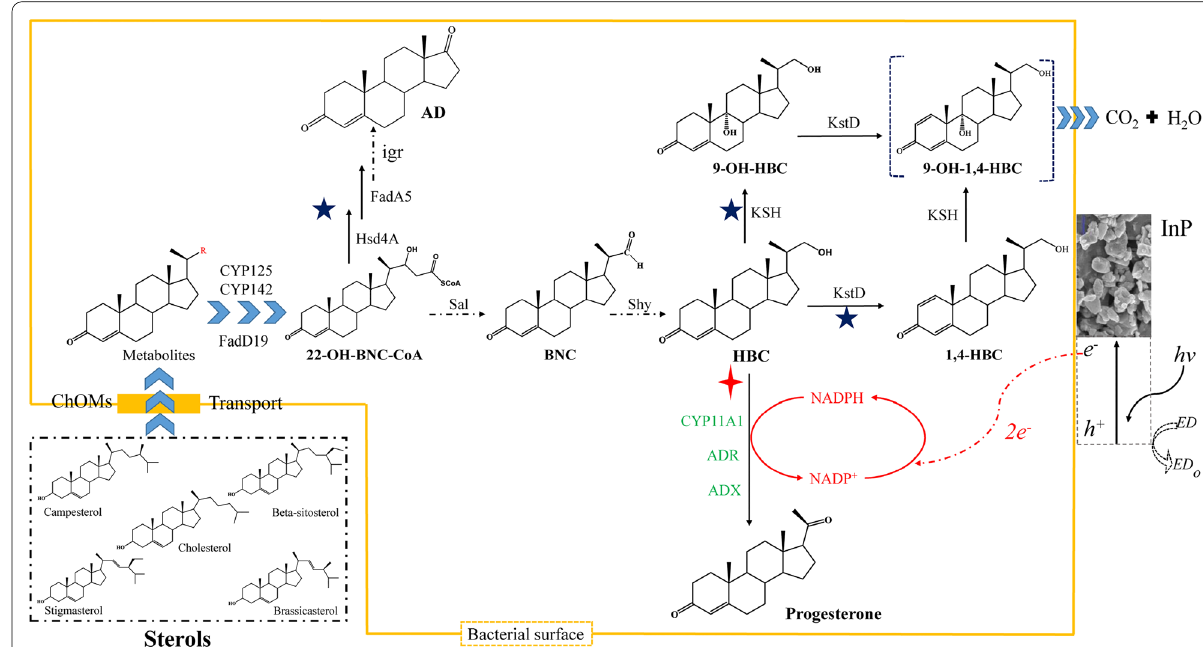
Fig. 1 Progesterone biosynthesis schematic in InP–( M. neoaurum ) biohybrids . The schematic depicts an abbreviated overview of the progesterone pathway, beginning with this work’s carbon source sterols. The blue star shows these branch points or building blocks were deleted in this study. The red cross indicates the focus of this study, which is the putative next pathway as performed by the cytochrome P450 (CYP11A1) and its reductase partners. The surface shows the process of cellular NADPH regeneration by photogenerated electrons from InP nanoparticles. h + : electron hole, e − : electron, ED: electron donors, ED o : oxidized electron donors, ChOMs: cholesterol oxidase transport